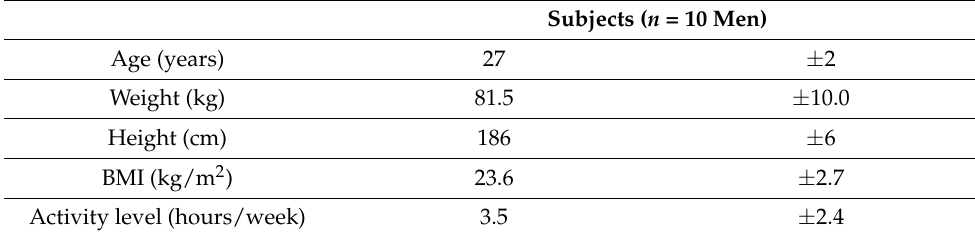
Table 1. Subject characteristics.